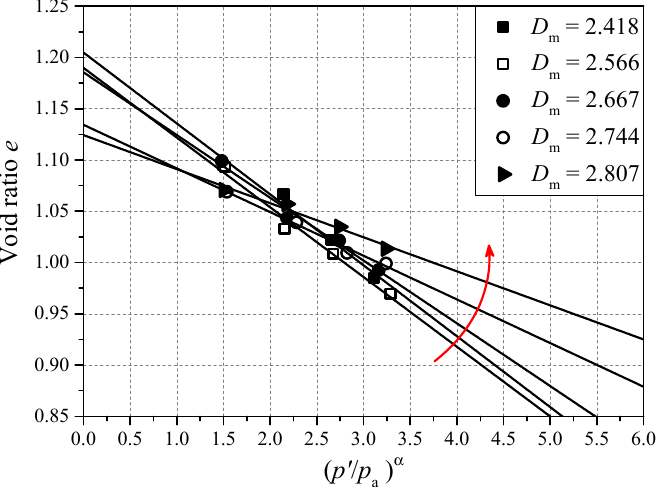
Figure 8. The critical state lines in the e –( p ′ / p a ) α plane of the calcareous sand with different fractal dimensions.